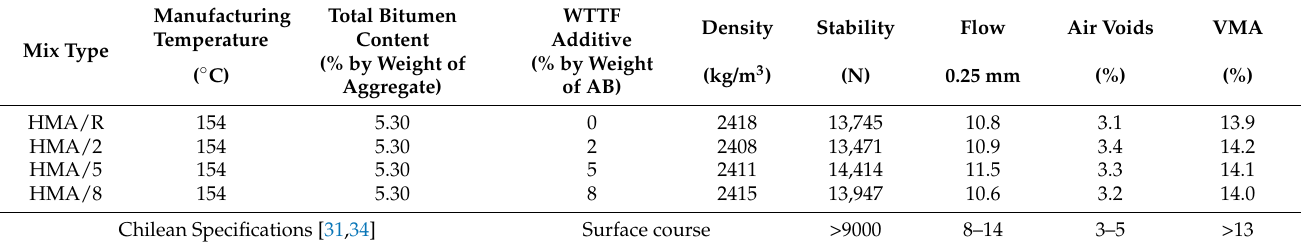
Table 3. Design parameters for design of evaluated